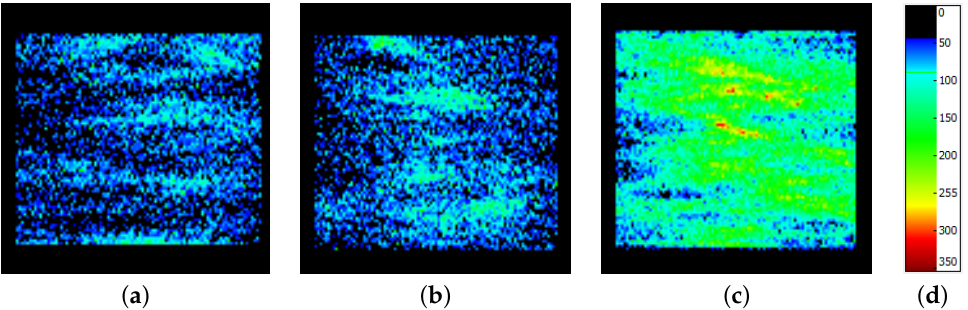
Figure 5. MRI of heat-treated Beishan granite. ( a ) 25 ◦ C ( b ) 200 ◦ C ( c ) 600 ◦ C ( d ) legend.